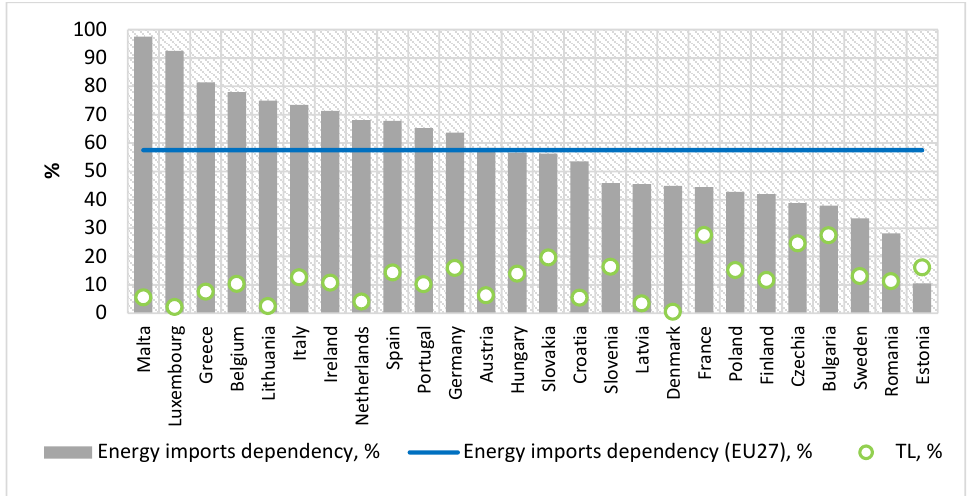
Figure 6. Energy imports dependency, 2020 (based on the Eurostat’s data (ec.europa.eu/eurostat/, accessed on 17 August 2022); © European Union, 1995 – 2022).